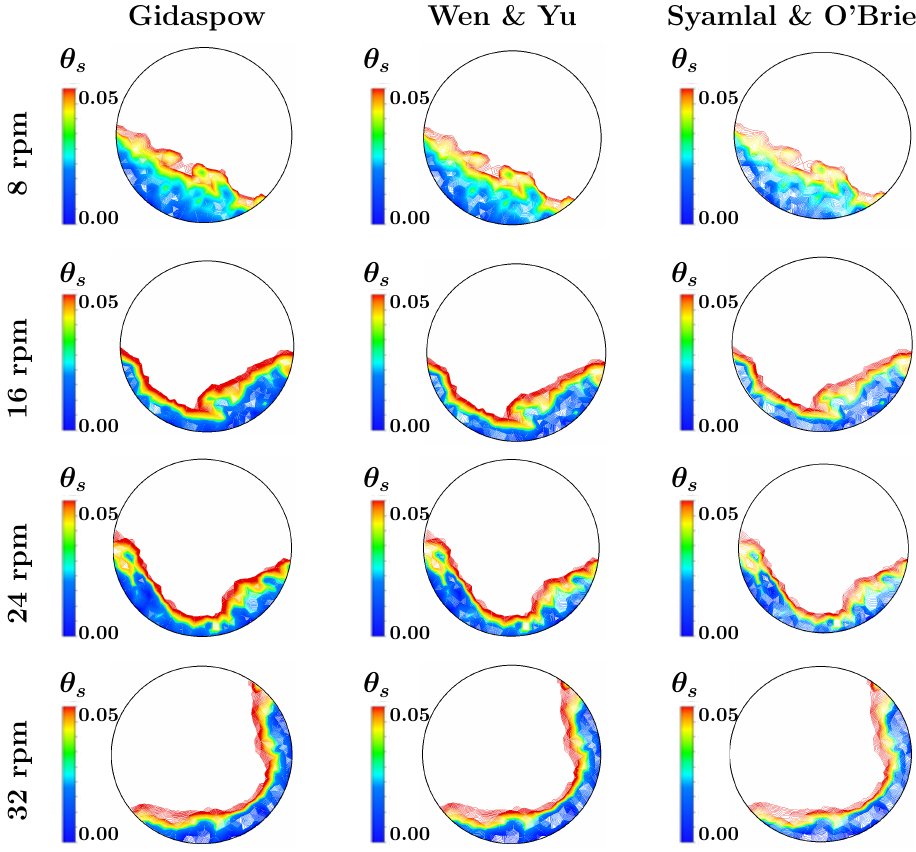
Figure 9. Axial snapshots of the granular temperature Θ s (m 2 16, 24, and 32 rpm with the three studied drag models at the end time of 200